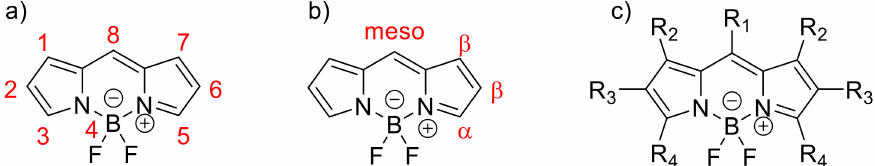
Figure 1. 4,4-difluoro-4-bora-3a,4a-diaza-s-indacene (BODIPY) core. ( a ), IUPAC (International Union of Pure and Applied Chemistry) numbering. ( b ), alpha, beta, and meso designation. ( c ), investigated